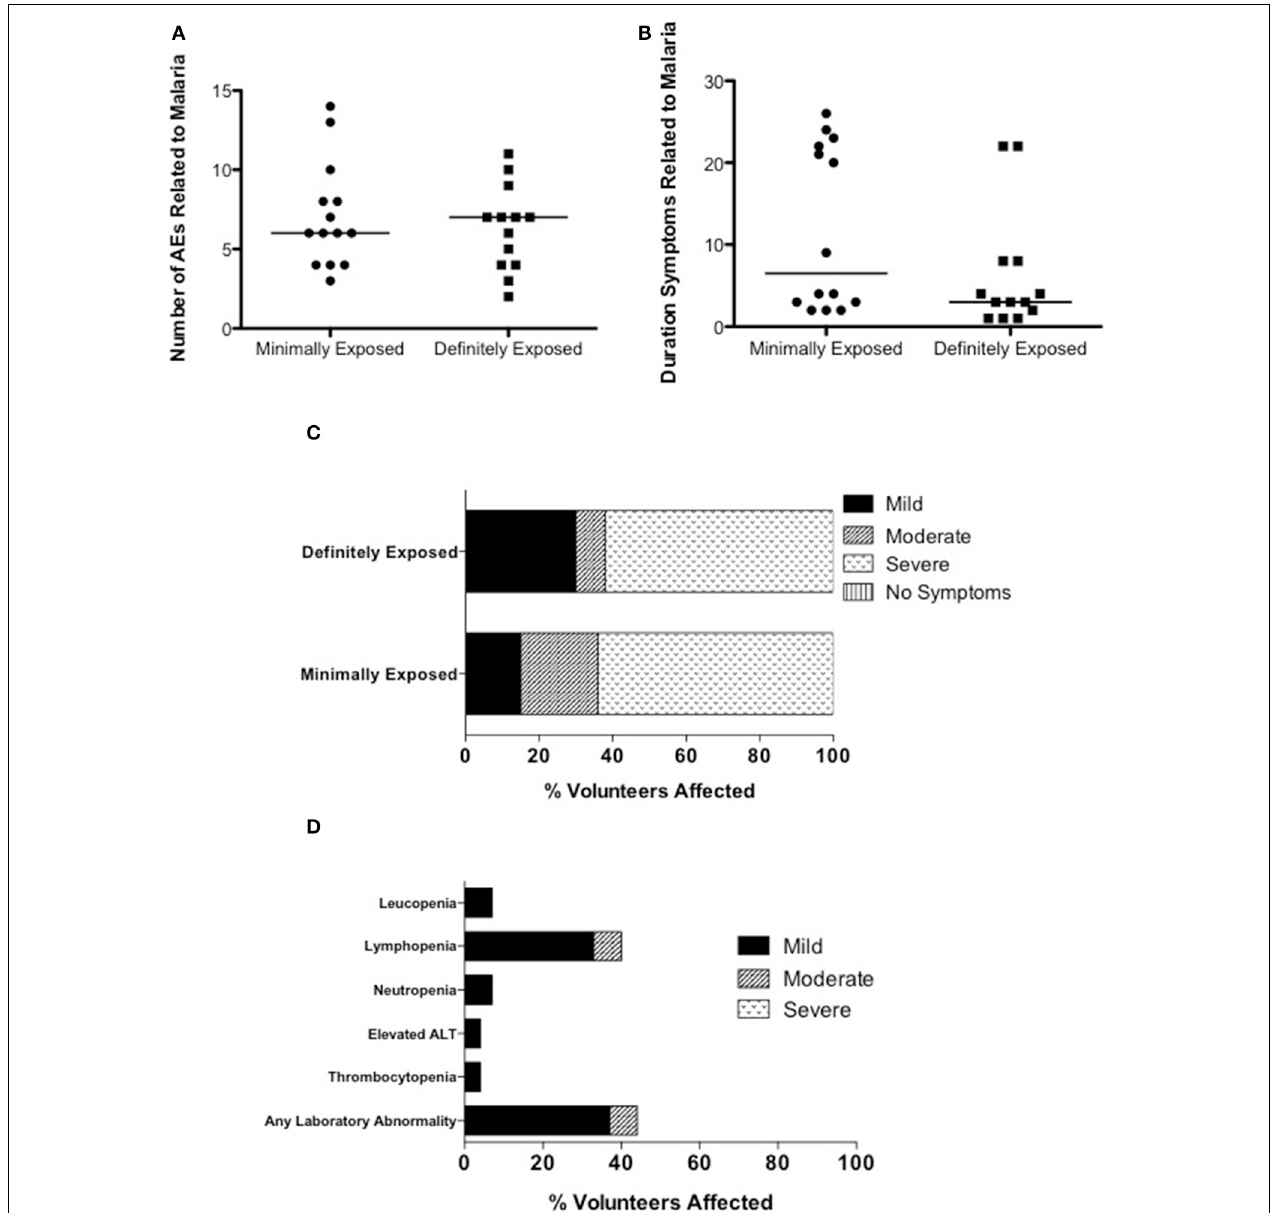
FIGURE 3 | Analysis of adverse events associated with clinical malaria. (A) Comparison of the total number of AEs (excluding laboratory AEs) deemed possibly, probably or definitely related to clinical malaria infection in individuals diagnosed with malaria in Groups 1, 3, and 5 (Minimally exposed; mean = 7.1, median = 6.0) and Groups 2, 4, and 6 (Definitely exposed; mean = 6.3, median = 7.0) ( Mann–Whitney test ; p = 0 . 746). The median value is represented by a straight line through each plot. (B) Comparison of the duration of symptoms deemed possibly, probably or definitely related to clinical malaria infection in individuals diagnosed with malaria in Groups 1, 3,